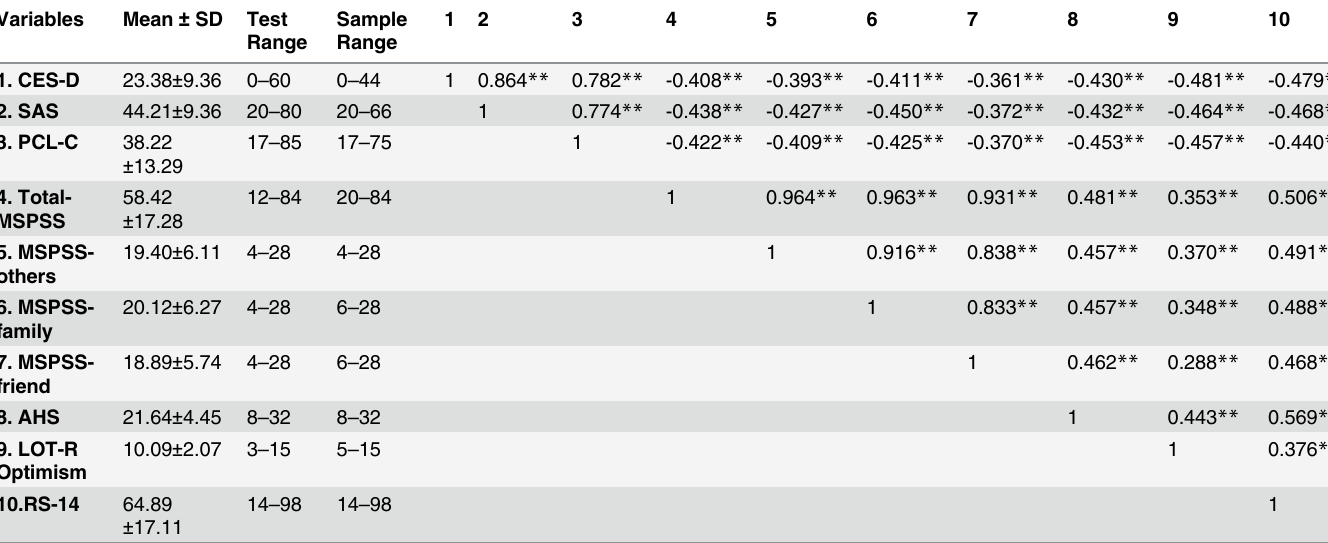
Table 3. Means, standard deviation, range and zero-order correlations (Pearson ’ s r) among study variables. Variables Mean ± SD Test Range